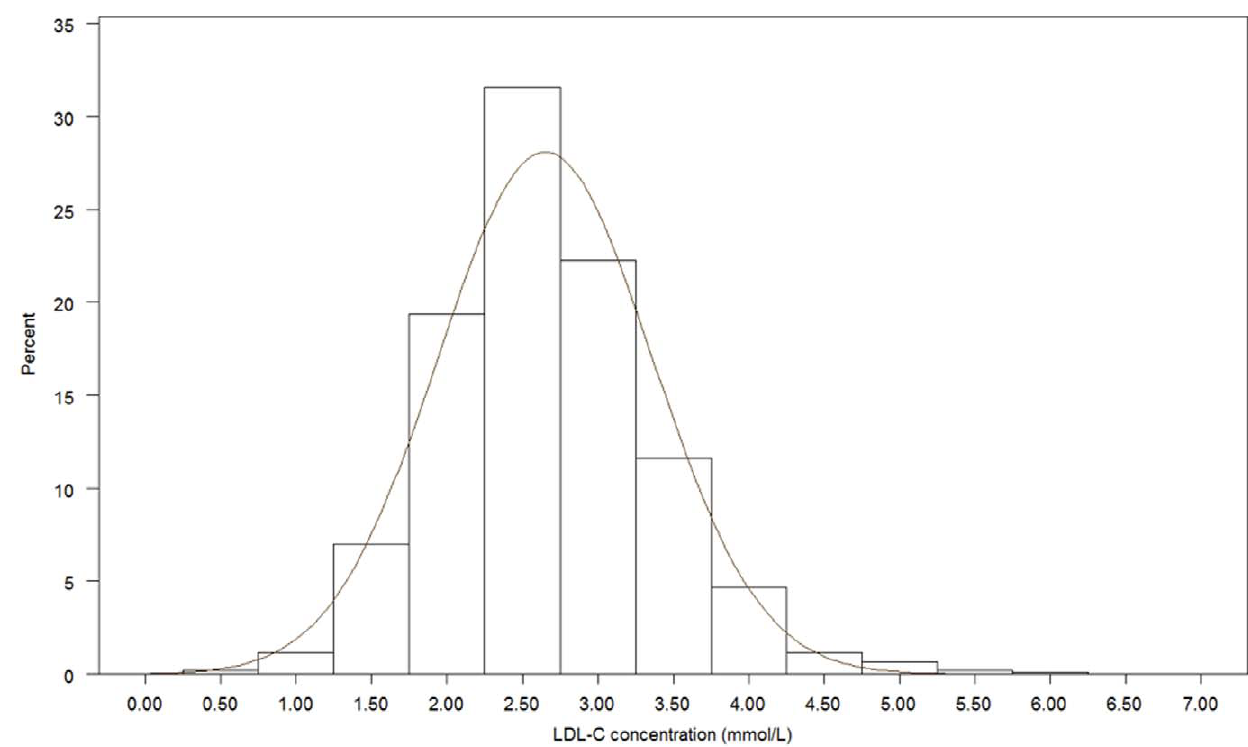
Figure 3. Histogram for the LDL-C values in patients on pravastatin.